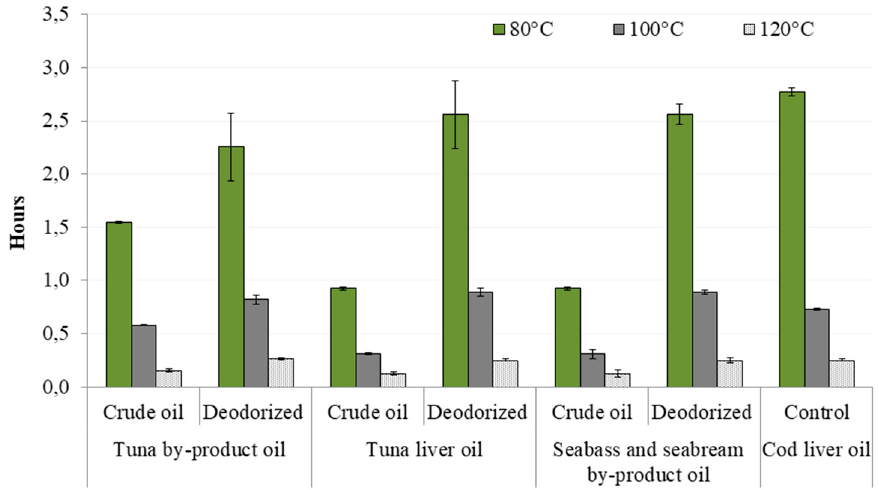
Figure 1. The oxidative stability ( n = 18) of crude and deodorized (refined) oils from tuna by-products, tuna liver, seabass and gilthead seabream by-products, and cod liver oil